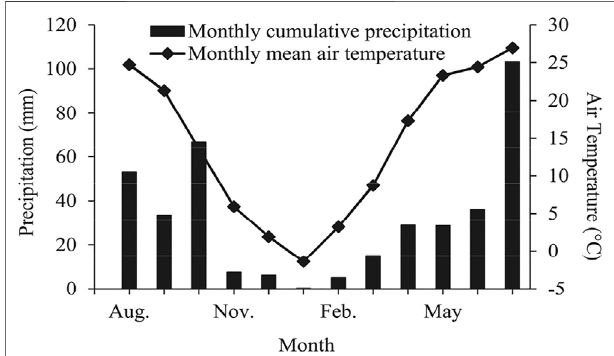
FIGURE 1 | Climatic data during the study period from August 2016 to July